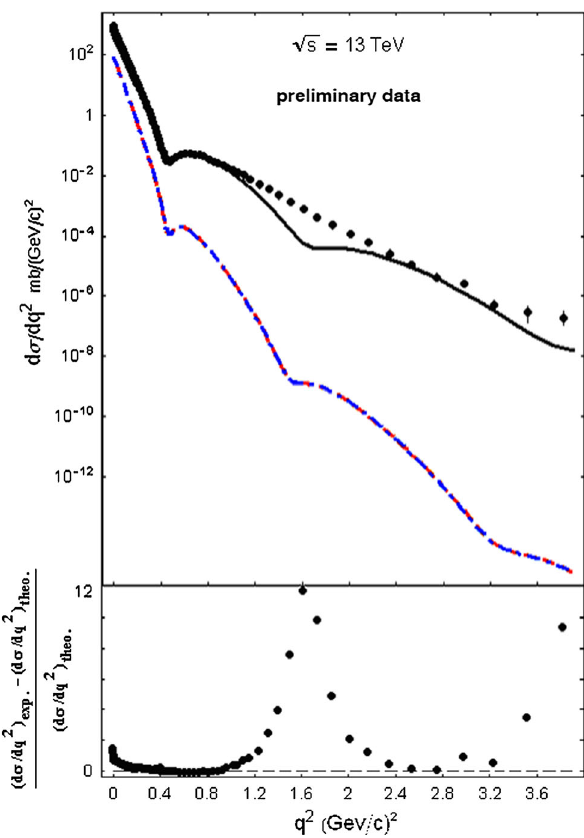
Fig. 2 Same as Fig. 1 for 8 TeV. The experimental data are taken from [4,8]